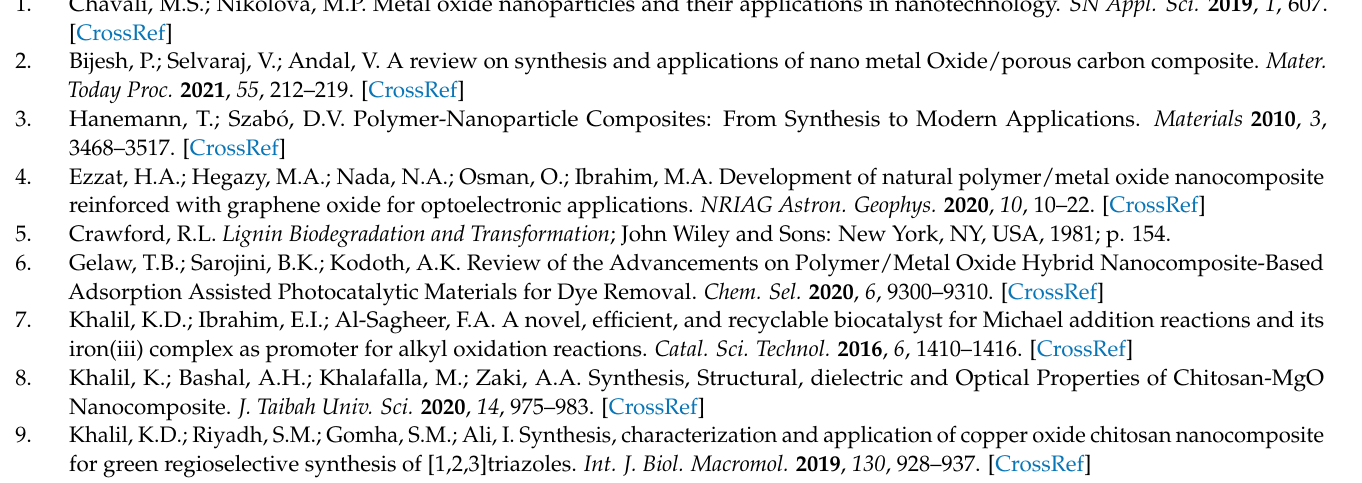
Figure S2. Comparative FTIR spectra of chitosan (A) and chitosan-strontium oxide nanocomposite (B) (10 wt.%). Figure S3. FESEM of chitosan (A), strontium oxide nanoparticles (B), and chitosan-SrO composite, 10 wt.% (C). Figure S4. Energy Despersive Spectroscopy of chitosan-SrO